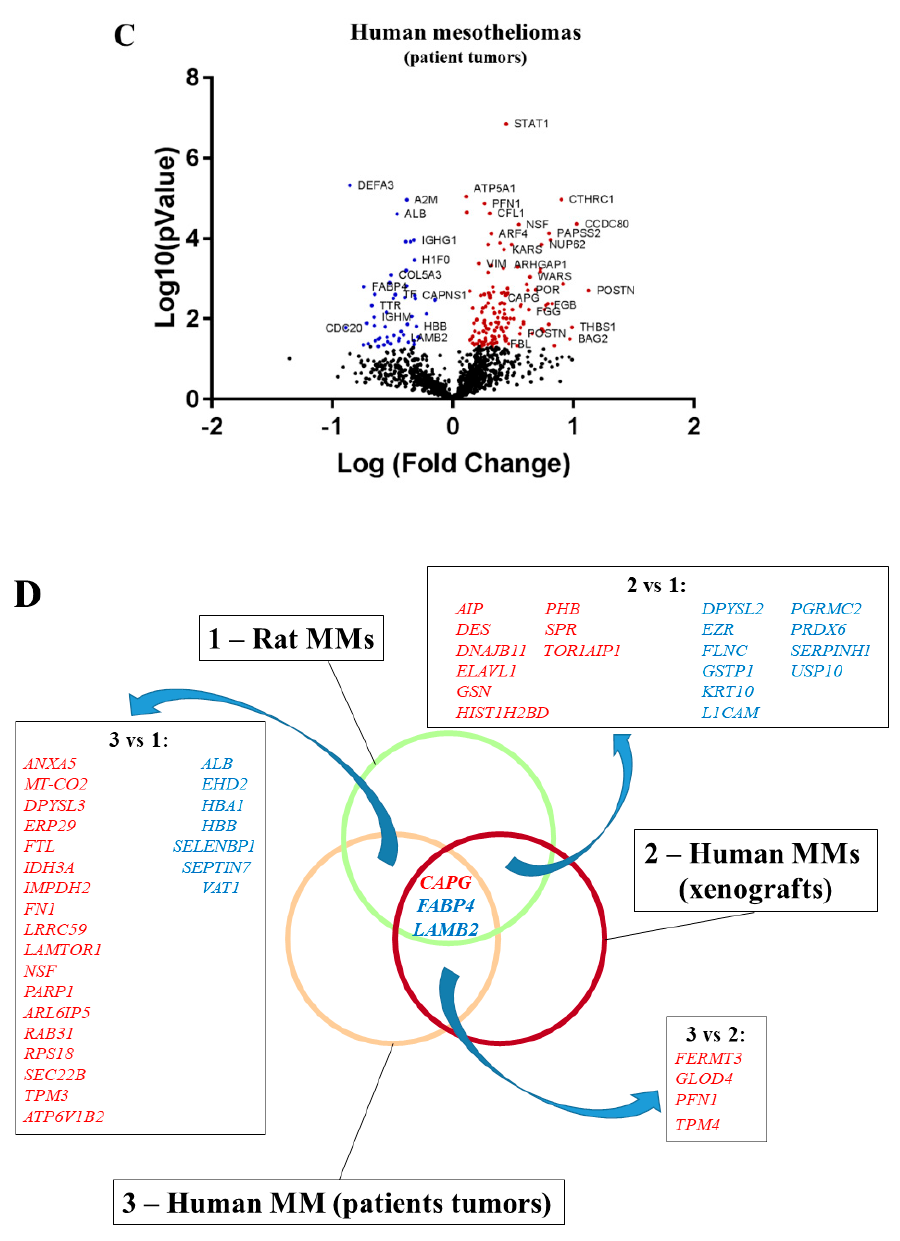
Figure 2. Volcano plots and schematic representation of the comparative proteomic analyzes. ( A ), Volcano plot of the comparison of the three invasive rat MM tumors (F4-T2, F5-T1, and M5-T1) versus the noninvasive one, (M5-T2). ( B ), Volcano plot of the comparison of Meso 163 versus Meso 34 xenografts of human MM tumors grown in immunodeficient mice. ( C ), Volcano plot of the comparison of human MM tumors from patients, sarcomatoid versus epithelioid subtypes. The locations of CAPG (in red), FABP4 and LAMB2 (in blue) are indicated in the three volcano plots. ( D ), Schematic representation of the comparative proteomic analyzes. The three different sources of MM tumors are illustrated by the green (Rat MM), brown (xenografts of human MM grown in NOD SCID mice) and orange (human MM from patient tumor samples) circles. The green circle represents the 433 proteins showing significant changes in abundance ( p < 0.05) between the three invasive rat MM tumors versus the noninvasive one. The brown circle illustrates the 133 proteins showing significant changes in abundance ( p < 0.05) between Meso 163 (MM163) and Meso 34 (MM34) xenografts. The orange circle represents the 191 proteins affected by significant changes in abundance ( p < 0.05) between the two sarcomatoid versus the two epithelioid MM tumors from patients. Genes coding for proteins exhibiting common significant changes are given for homo sapiens in italics (increase in red, decrease in blue).